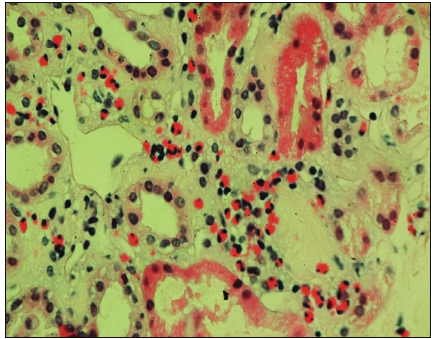
Figure 2: Eosinophilic interstitial infiltrates in renal tissue.